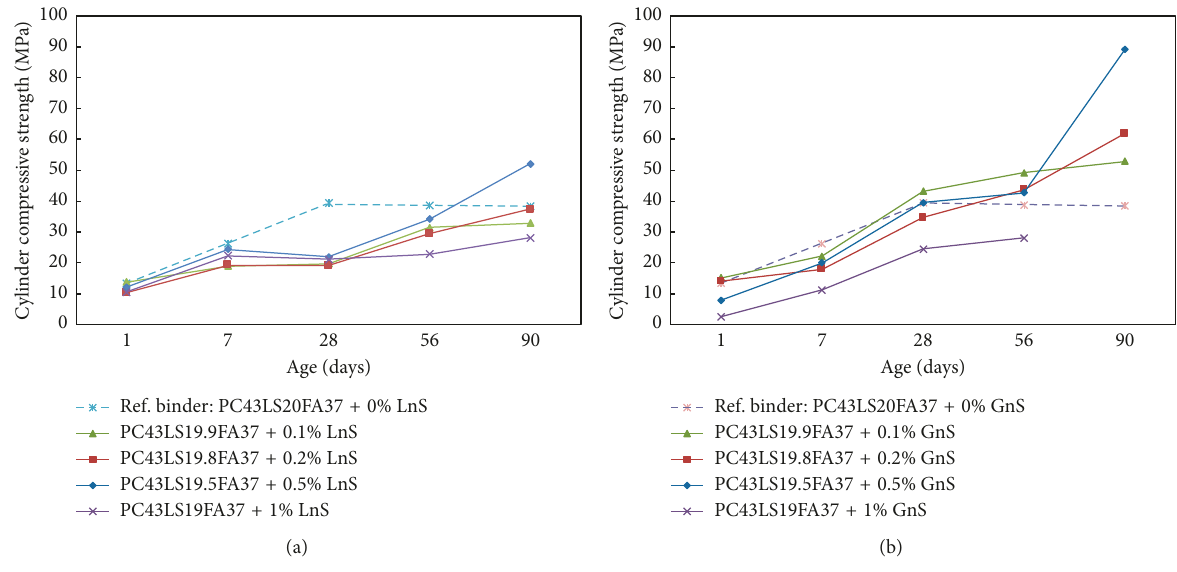
Figure 5: Cylinder compressive strength of (a) LnS and (b) GnS nanocomposite binders based on